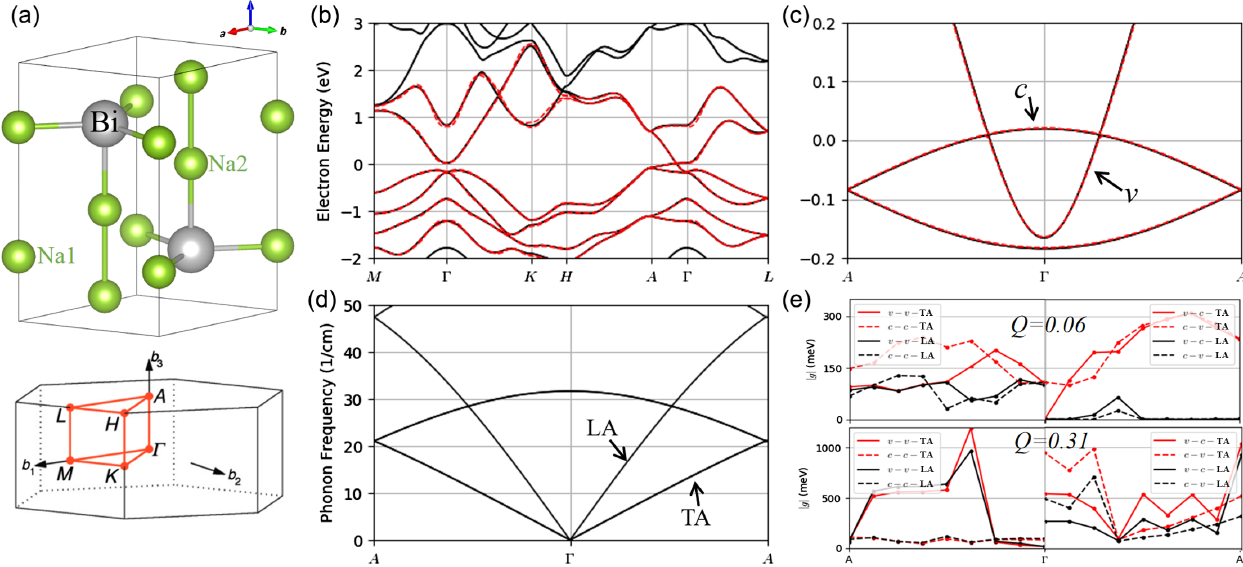
FIG. 7. (a) Upper: crystal structure of Na 3 Bi. Two Na1 atoms (green), four Na2 atoms (green), and two Bi atoms (gray) lie at 2 b , 4 f , and 2 c Wyckoff positions, respectively. Bottom: Brillouin zone (BZ) and high-symmetry path used in the electron and phonon calculations. (b) Band structures (black lines) from DFT of Na 3 Bi with SOC included. Twelve low-energy bands (red lines) based on maximally localized Wannier functions using the prior selected columns of the density matrix (SCDM) method. (c) Enlarged view of band structure near Γ point. c and v refer to the conduction and valence bands near Fermi level. (d) Acoustic phonon dispersion in the Z - Γ - Z path with rotation symmetry. Longitudinal acoustic (LA) and degenerate transverse acoustic (TA) phonon branches are almost linear until the BZ boundary. (e) j g j -matrix elements of TA and LA phonon modes coupling to the c and v bands. Upper: in the long wavelength limit where we select a Q ¼ 0 . 06 (in unit of reciprocal lattice constant) example, the left is the intraband coupling and the right is the interband coupling. Red (balck) lines refer to TA (LA) phonon modes and solid (dashed) lines refer to valance (conductance) band. Bottom: in the finite wave vector case where we select a Q ¼ 0 . 31 (the wave vector connecting two Dirac cones) phonon mode. Color and line type follow the same convention as the upper